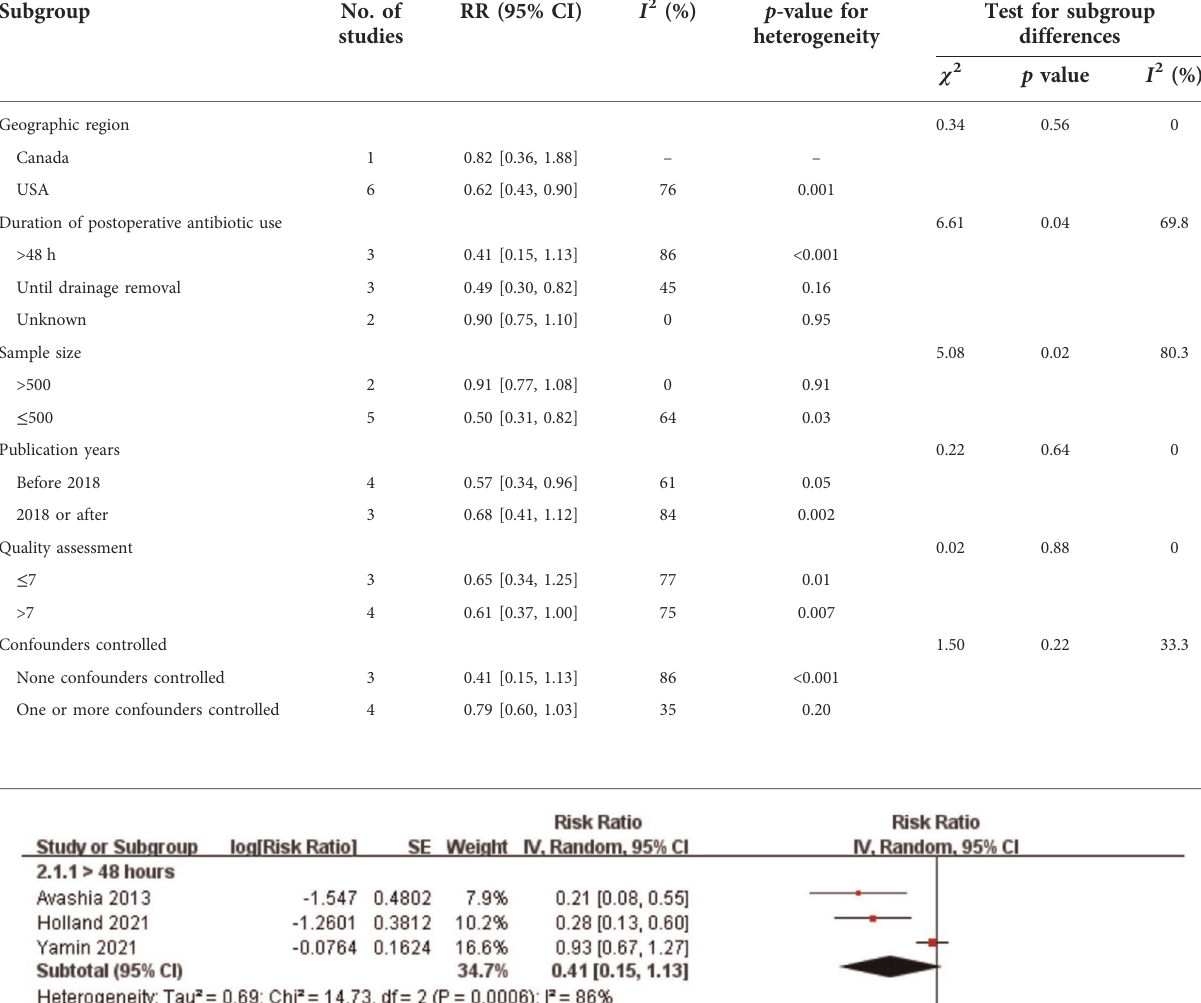
TABLE 3 Subgroup analyses for the association between antibiotic use and infection after breast implantation.